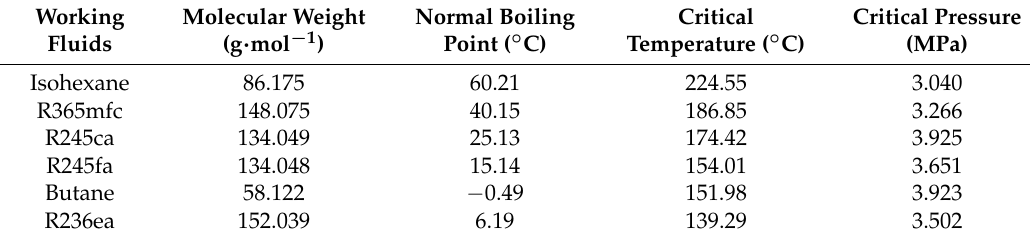
Table 3. Properties of the six organic working fluids.